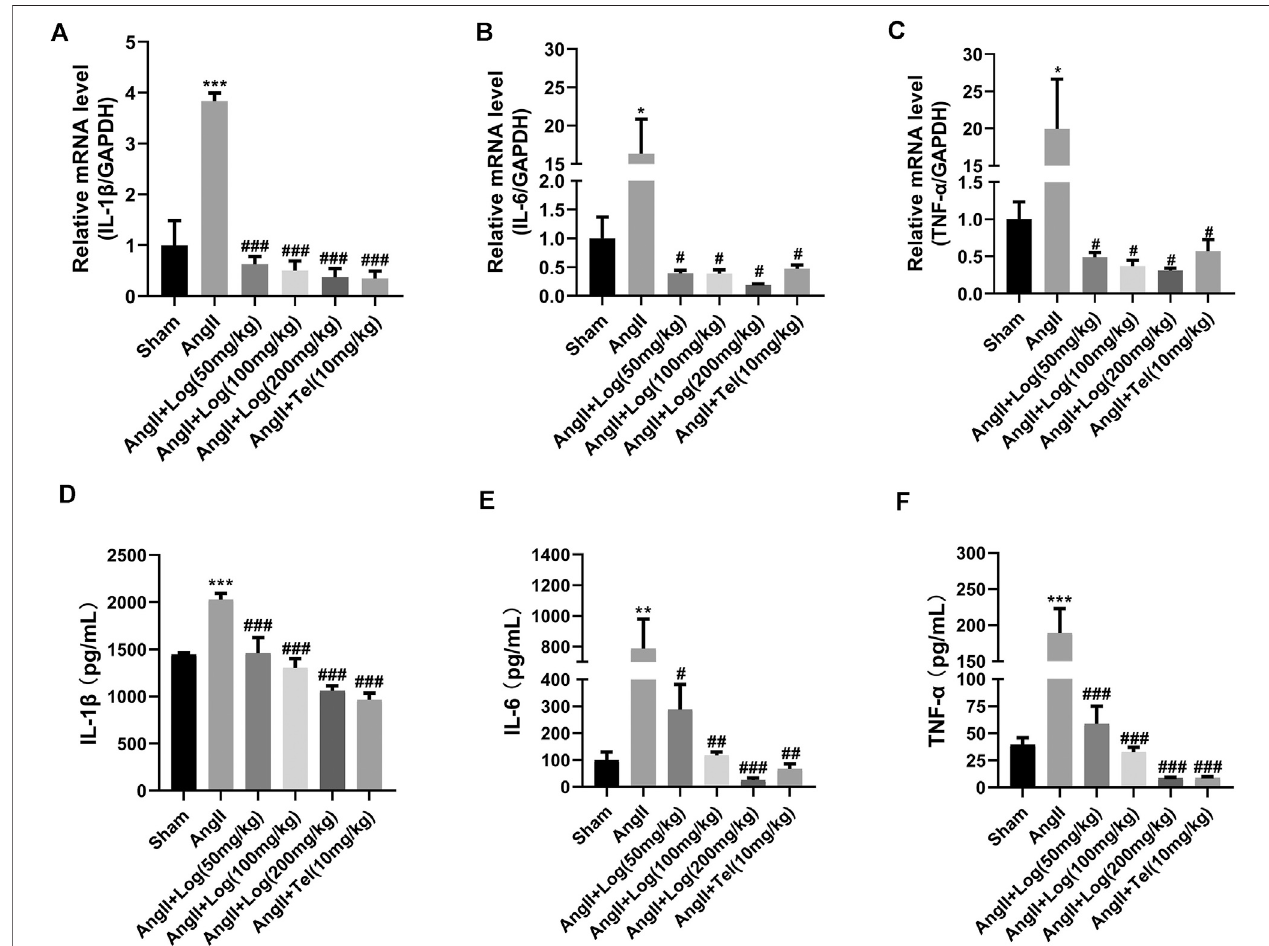
FIGURE3 | Loganin counteractsin fl ammation stimulated byAng II in mice. (A – C) The mRNA expression ofIL-1 β , IL-6, and TNF- α is examined by RT-PCR ( n (cid:2) 3). (D – F) Circulating IL-1 β , IL-6, and TNF- α serum levels. These pro-in fl ammatory factors are tested by ELISA ( n (cid:2) 3). Data are expressed as mean ± SD. * p < 0.05, ** p < 0.01, *** p < 0.001 vs the sham group; # p < 0.05, ## p < 0.01, ### p < 0.001 vs the Ang II – treated group. Telmisartan (Tel) is a positive control